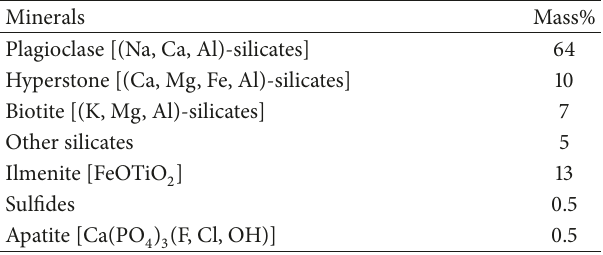
Table 2: Traced minerals in the norite.